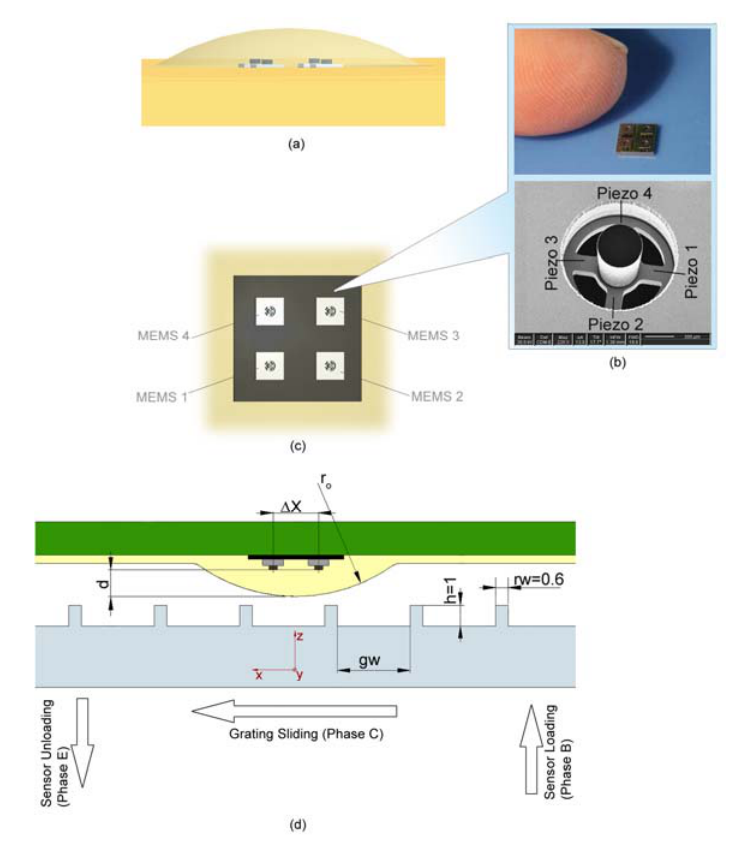
Figure 1. (a) 3D design of the tactile sensor array. (b) Top: The 2×2 MEMS array compared with human finger; bottom: a FIB image of the MEMS sensor. (c) Top view of the sensor array. (d) Schematic showing a cross section of packaging design and grating dimensions. Groove width gw ranged from 2.0 mm to 3.5 mm (see Table1), while ridge height h and ridge width rw had fixed values indicated (in mm) in figure. The phases of the experimental protocol are also